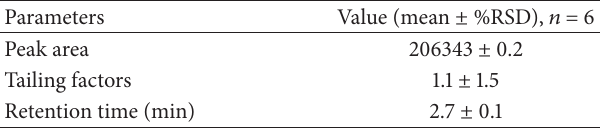
Figure 2: RP-HPLC chromatogram of (a) standard, (b) assay sample, and (c) placebo sample of rabeprazole sodium.